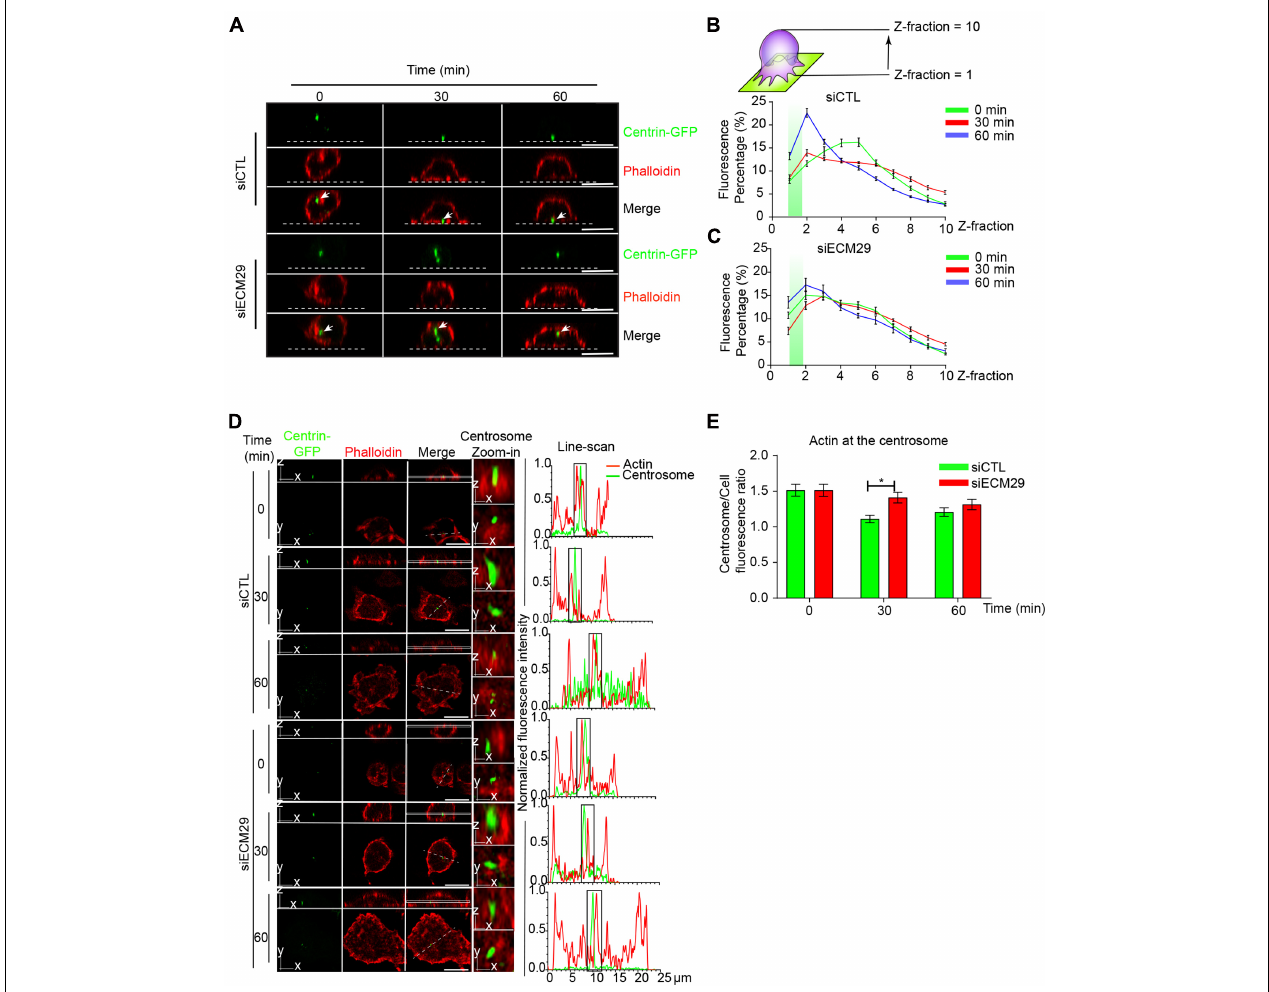
FIGURE 6 | Centrosome polarization and perinuclear actin clearance rely on Ecm29: (A) Representative X/Z confocal images of centrin-GFP expressing control (siCTL) and Ecm29-silenced (siECM29) B cells activated on antigen-coated coverslips for different time points, stained for F-actin, phalloidin are shown. White arrows indicate the centrosome. The white dashed line represents the position of the coverslip. (B,C) Quantification of centrosome fluorescence intensity along the Z dimension from the coverslip to the upper cell limit of control and Ecm29 silenced B cells, respectively. The green rectangle represents the synaptic Z area (between 1 and 2 Z-fraction), and the maximum value of the curve represents the localization of the centrosome in the Z dimension. N = 2. Cells > 19. (D) Representative Ayriscan images of centrin-GFP expressing control and Ecm29-silenced B cells activated on antigen-coated coverslips for different time points, labeled for F-actin, phalloidin. Magnifications of the centrosome (9 µ m 2 ) and the fluorescence intensity distribution of centrin-GFP (green) and phalloidin (red) across the cell (dashed white lines) are shown. White rectangles represent the X/Y position for images in Z. (E) Quantification of actin at the centrosome in D. N = 2. Cells > 45. * p < 0.05. Kruskal–Wallis test with Dunn’s test, and Mann–Whitney test was performed for all statistical analyses. was performed for all statistical analyses. Mean with SEM lines (B,C) and bars (E) are shown. Scale bar = 10 µ